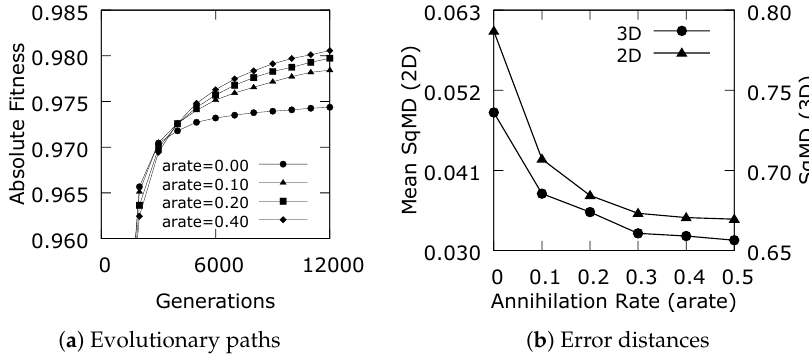
Figure 6. Effect of the annihilation rate (arate), hollow sphere